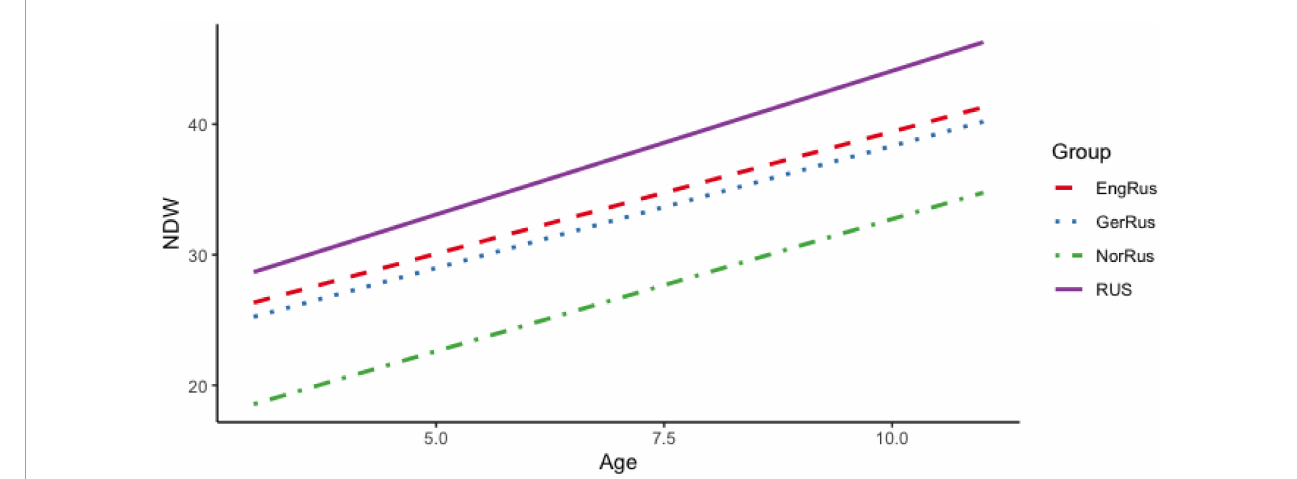
FIGURE1 Number of different words (NDW) per narrative in Russian heritage language (RHL) as a function of age and country.